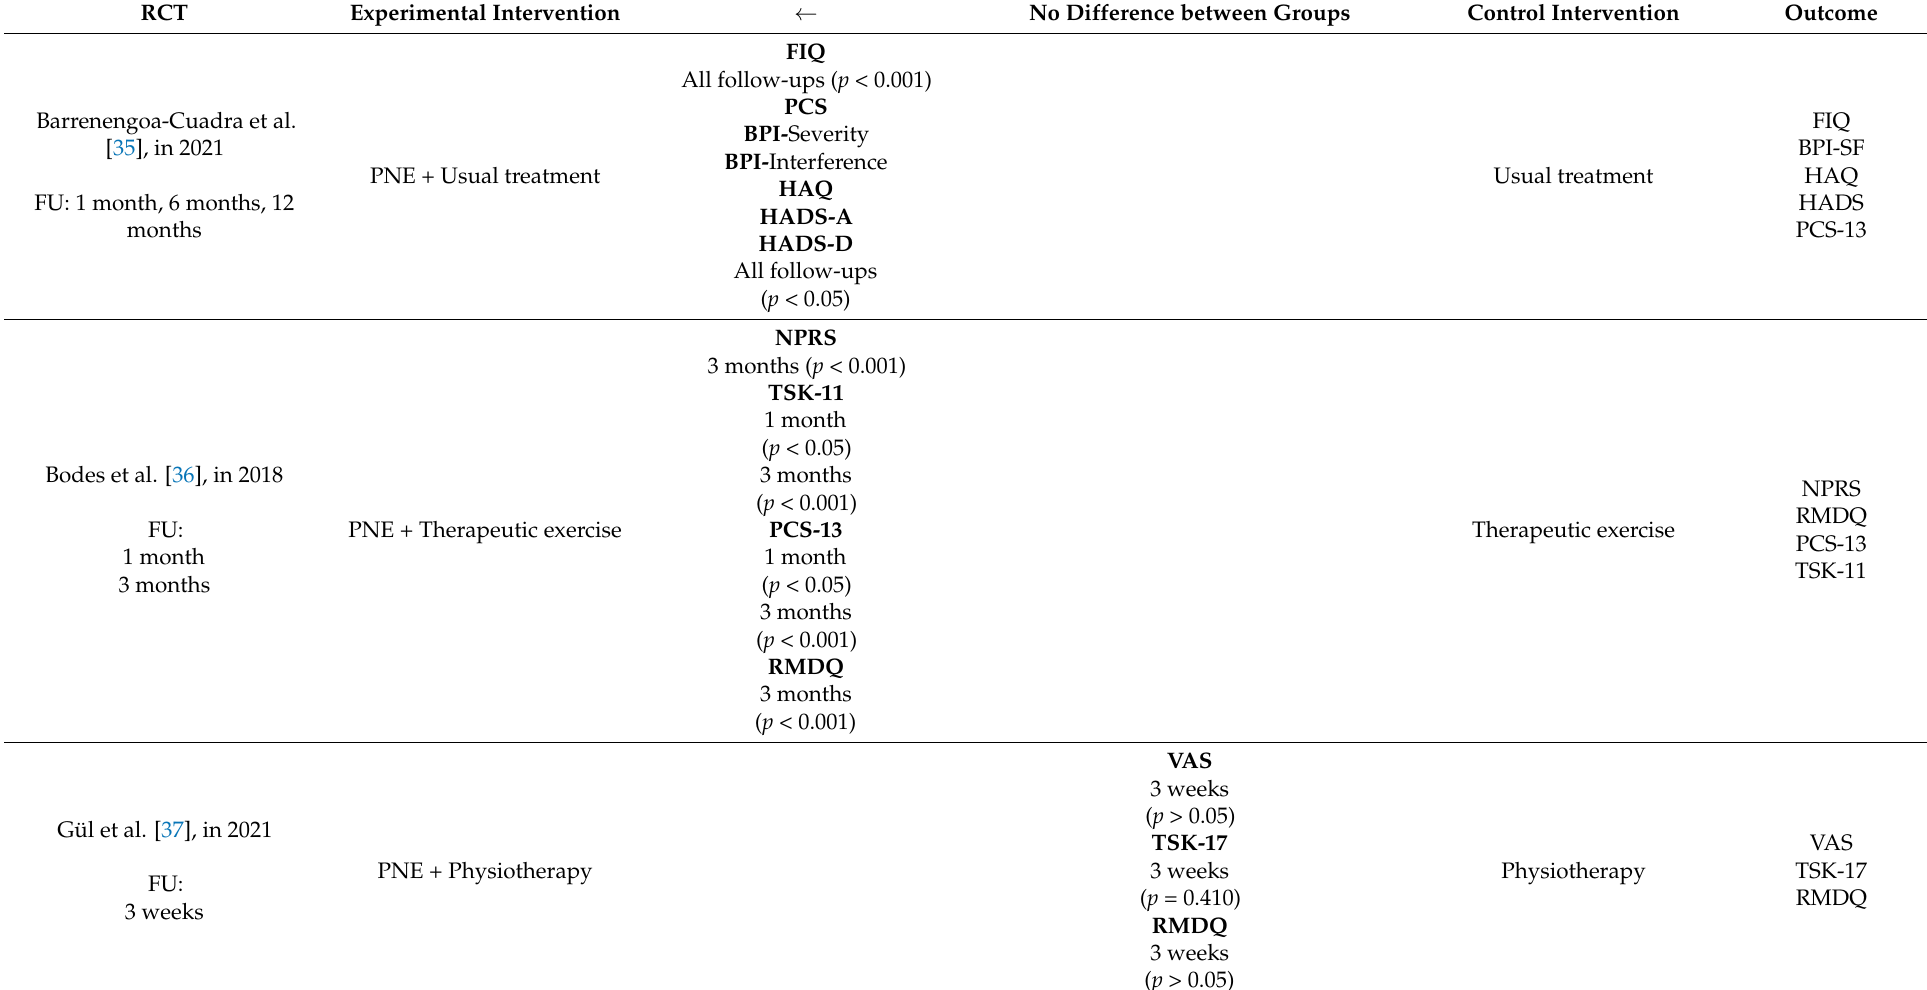
Table 6. Effectiveness of PNE based on between-group